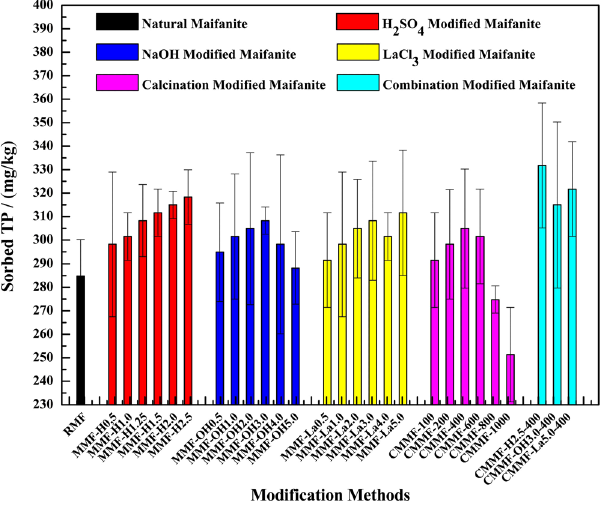
Figure 1. Effects of different RMF and MMF samples on adsorption of sediment